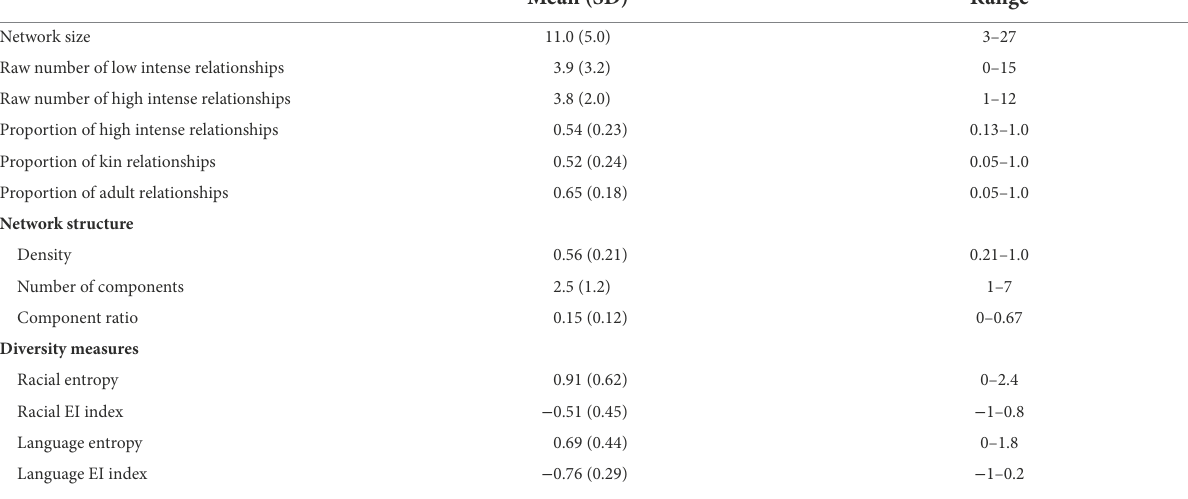
TABLE 1 Table of the social network